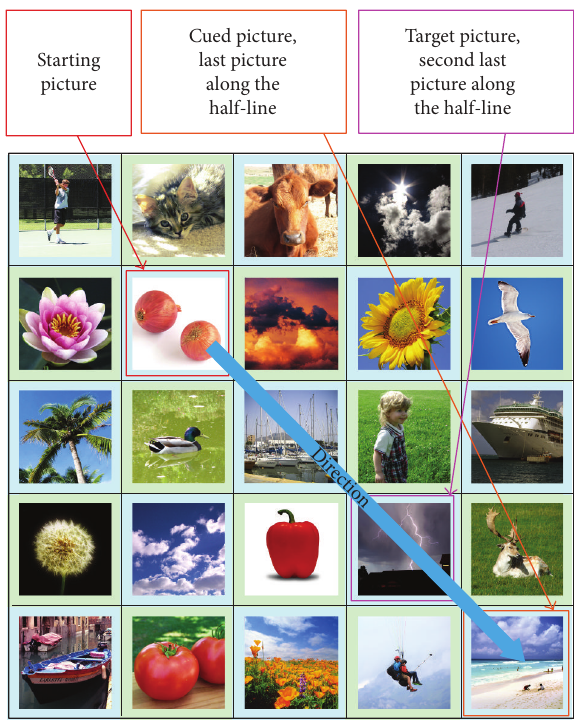
Figure 9: Scenario 2’s exception: cued picture is on the half-line and is the last